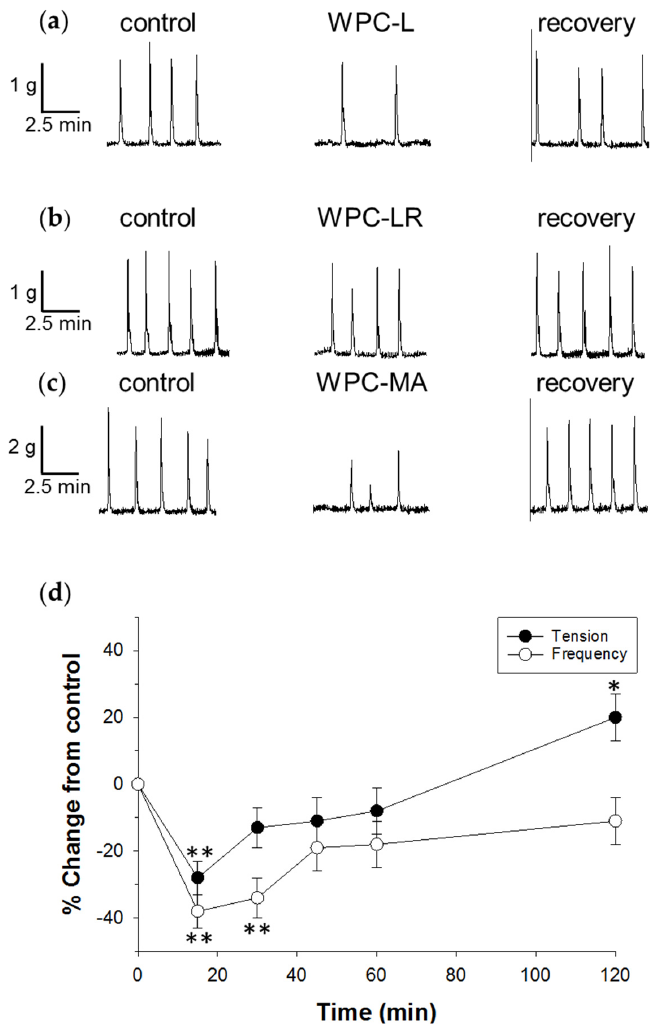
Figure 1. Effect of WPC on spontaneous muscle contractions in the rat distal colon. The last 10 min of a 15 min treatment exposure on spontaneous muscle contractions was measured relative to that in the last 10 min of a 60 min pretreatment control recording ( T = 0). Examples of raw data recordings from three separate tissue preparations show changes in muscle tension over time for the control, after addition of 1 mg/mL: ( a ) WPC ‐ L; n = 13; ( b ) WPC ‐ LR; n = 15; and ( c ) WPC ‐ MA; n = 12, and the last 10 min of recovery following a 60 min washout in Krebs buffer; ( d ) Time ‐ dependence of WPC ‐ MA effect shown as percent change in tension and frequency relative to the pretreatment control for a 60 min application showing pooled data from 12 experiments. Data show mean ± SEM. Asterisks indicate statistical significance (* p < 0.05, ** p < 0.01) of the treatment relative to control.